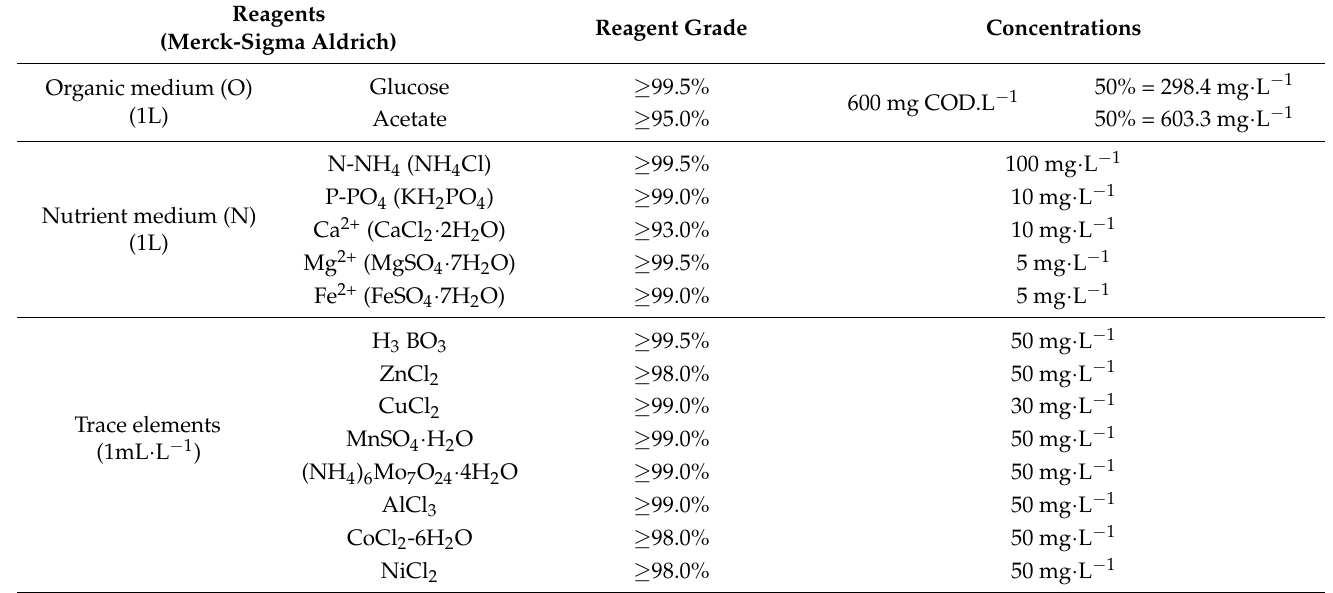
Table 2. Composition of synthetic